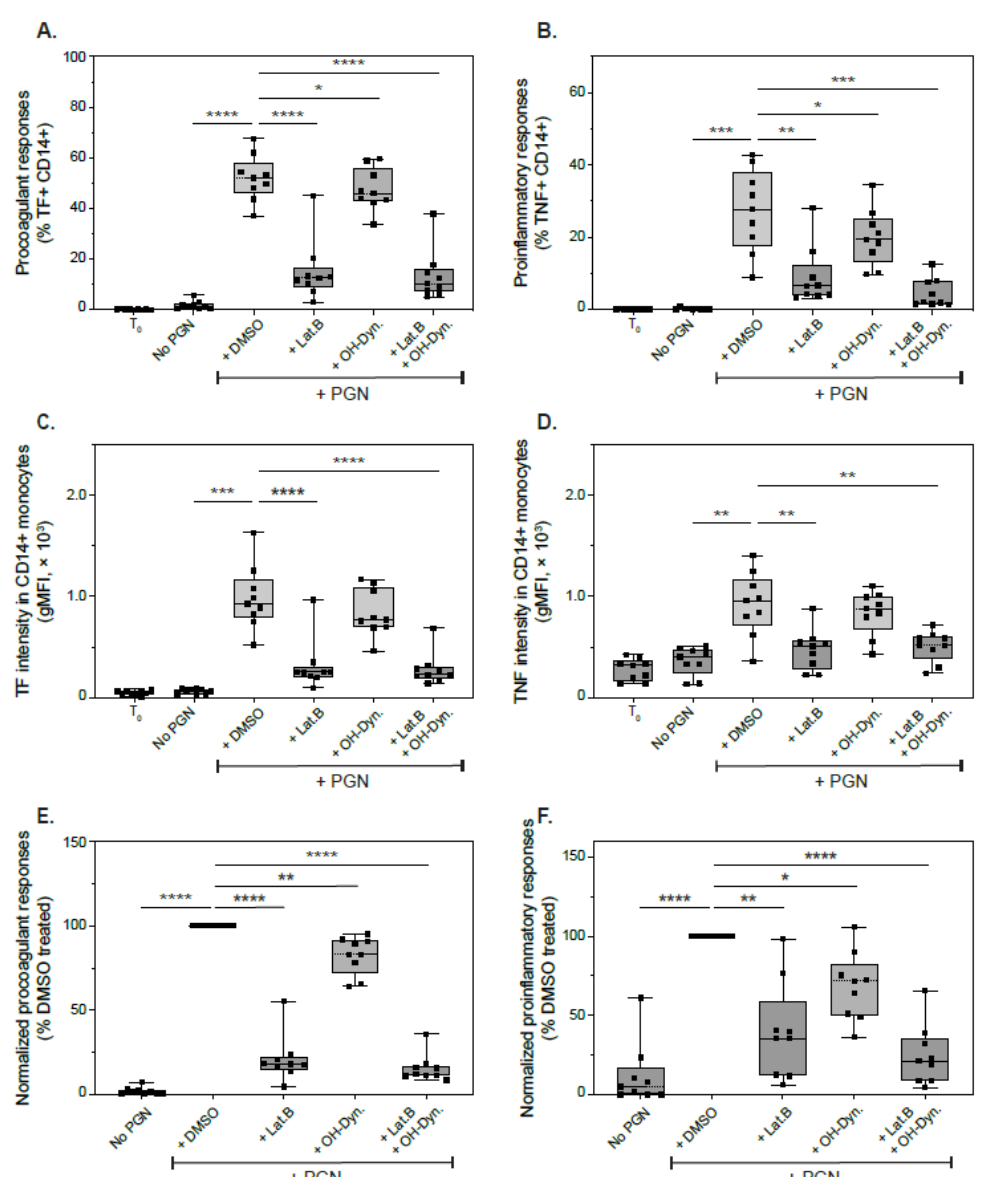
Figure 6. Modulation of immune responses to PGN after inhibition of actin and/or dynamin-dependent internalizations. Primary human PBMCs were mock-treated (DMSO) or treated with latrunculin B (Lat.B) or hydroxy-dynasore (OH-Dyn.) for 1 h, followed by 6 h stimulation with PGN (20 µg/mL) in the presence of brefeldin A. Inducible expressions of TF ( A , C , E ) or TNF ( B , D , F ) were assessed by flow cytometry after comparison with a paired unstimulated aliquot fixed at the start of the experiment (T 0 ). Data depict frequency of responsive monocytes ( A , B ), the geometric mean of fluorescence intensity of inducible antigens ( C , D ) and normalized induction of TF and TNF ( E , F ) after pairwise normalization to DMSO-treated cells ( n = 9). Statistically significant differences compared to PGN responses in the absence of the inhibitors (DMSO-treated cells) are depicted conventionally (* p < 0.05, ** p < 0.01, *** p < 0.001, **** p < 0.0001; RM ANOVA with Holm-Sidak’s multicomparisons test).